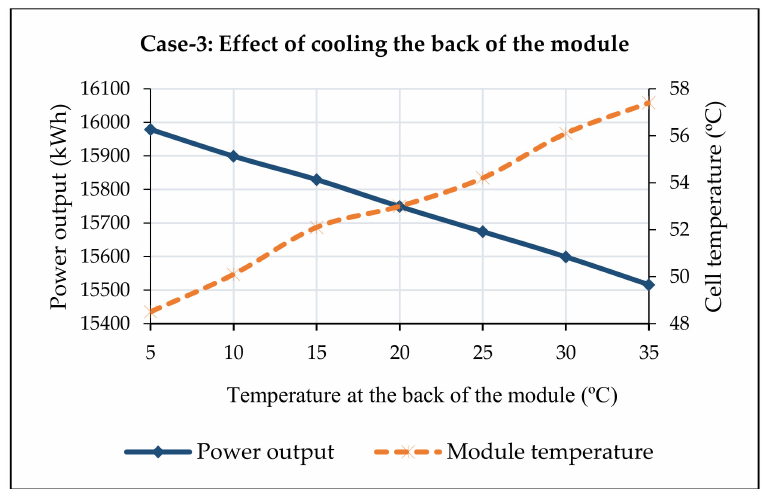
Figure 19. Effect of cooling the back of the